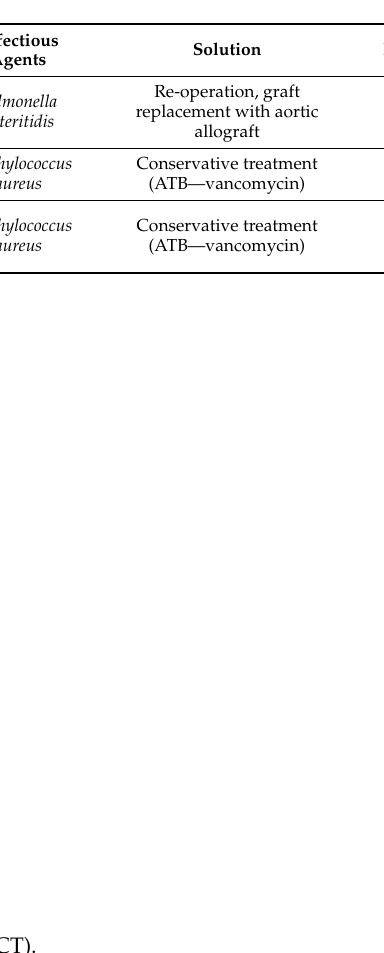
Table 3. Data of patients with silver graft infections.